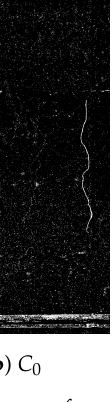
Figure 9. Change maps from PCA applied to different images. C 1 ( a ), C 0 ( b